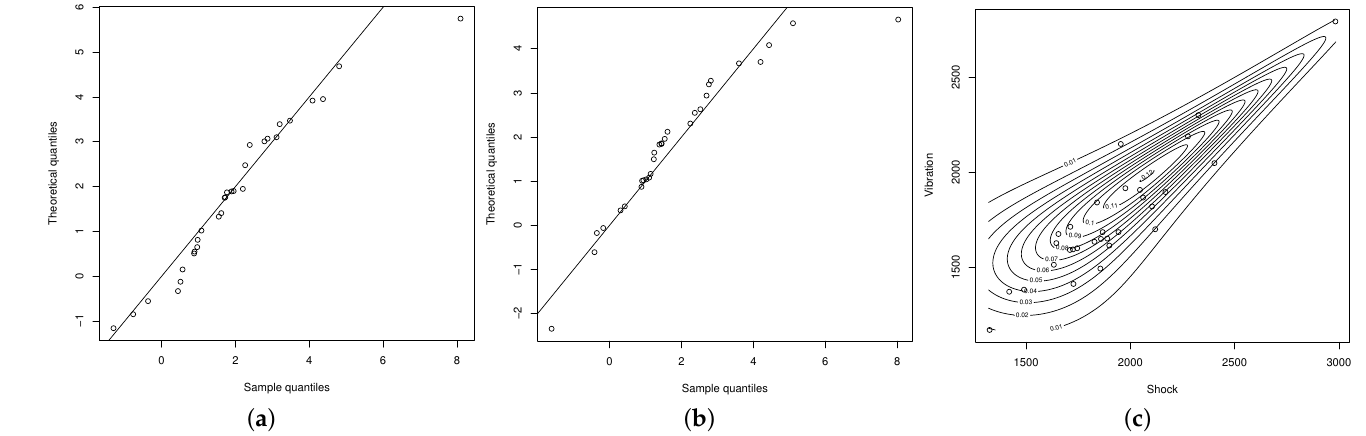
Figure 3. QQ-plots and contour plot: ( a ) Shock, ( b ) Vibration, and ( c ) contour plot of the BPHN